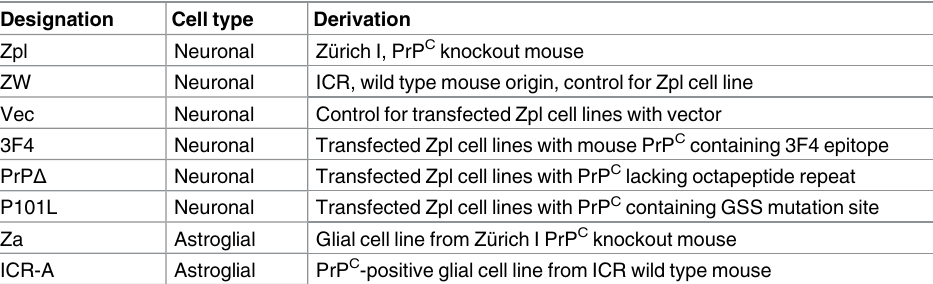
Table 1. Origin and derivation of cell lines.